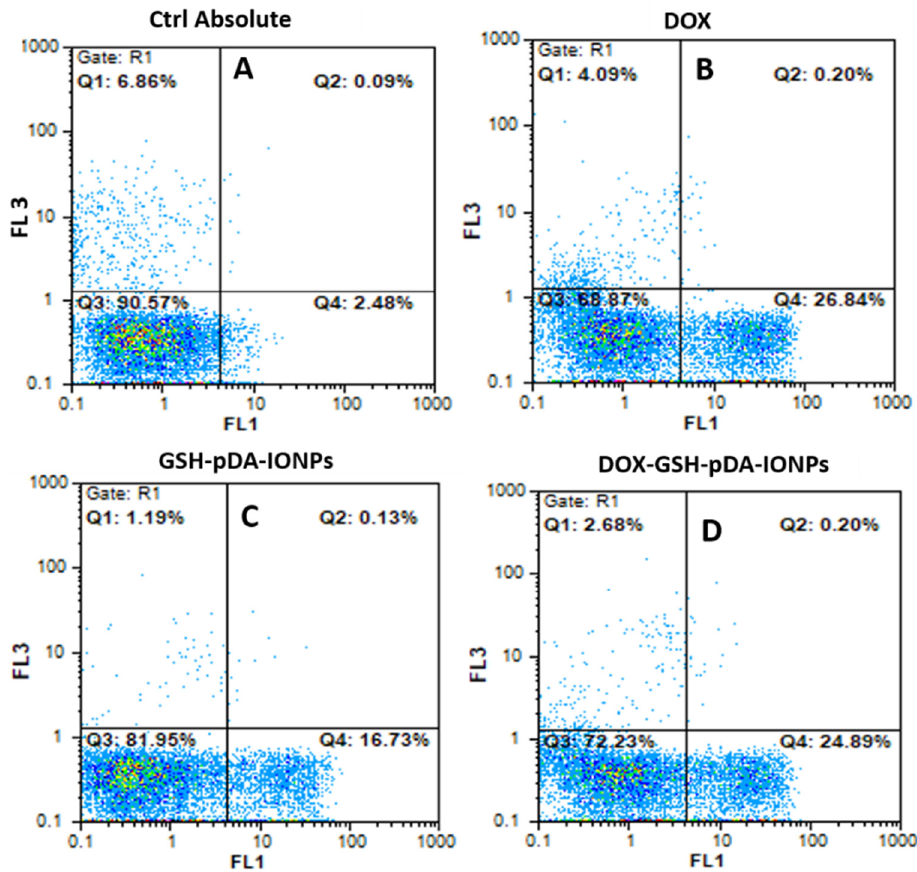
Figure 10. Representative dot plot of Annexin V-FITC/PI ((fluorescein isothiocyanate) detection kit with PI (propidium iodide) staining of PC3 (prostate cancer) cells incubated for 24 h A. Without any sample B. with DOX, C. GSH-pDA-IONPs and D. DOX-GSH-pDA-IONPs (flow cytometry: x axis (Fluorescence 1, FL1) Annexin V-FITC and y axis (FL3) propidium iodide). The Q1 quadrant represents unviable cells (PI positive and annexin negative). The Q2 quadrant represents cells that are in late apoptosis or necrosis (both annexin and PI positive). The Q3 quadrant represents viable cells (both annexin-FITC and PI negative). The Q4 quadrant represents cells in early apoptosis (annexin positive and PI negative).